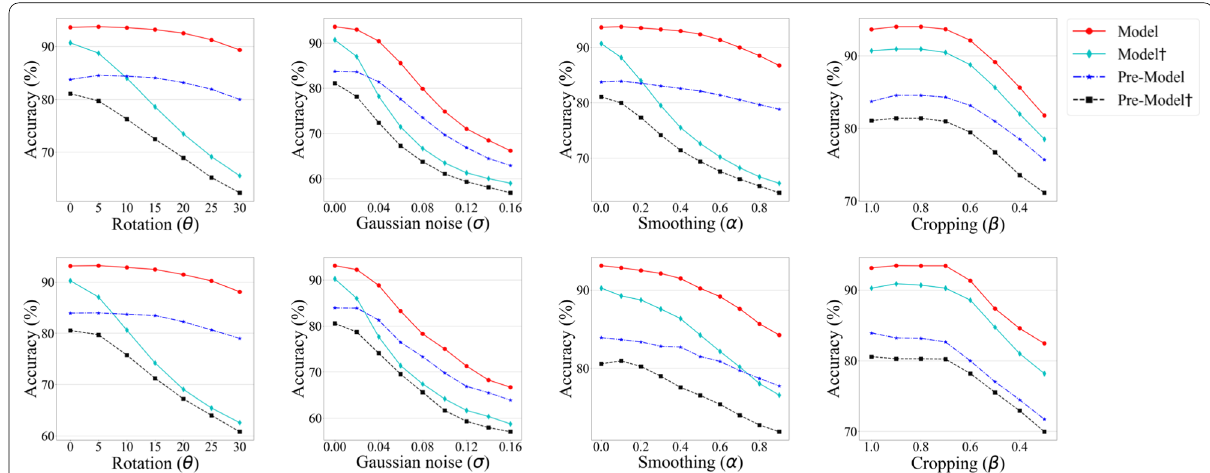
Fig. 10 Bit accuracy rate (%) under different attacks and intensities on remeshed Asiadragon (top) and remeshed Hand (bottom) dataset. Model (red), Model † (cyan), Pre-Model (blue) and Pre-Model † (black) are showed. † denotes training without the attack layers, Model represents the model trained on the remeshed dataset, and Pre-Model represents the model trained on the original dataset